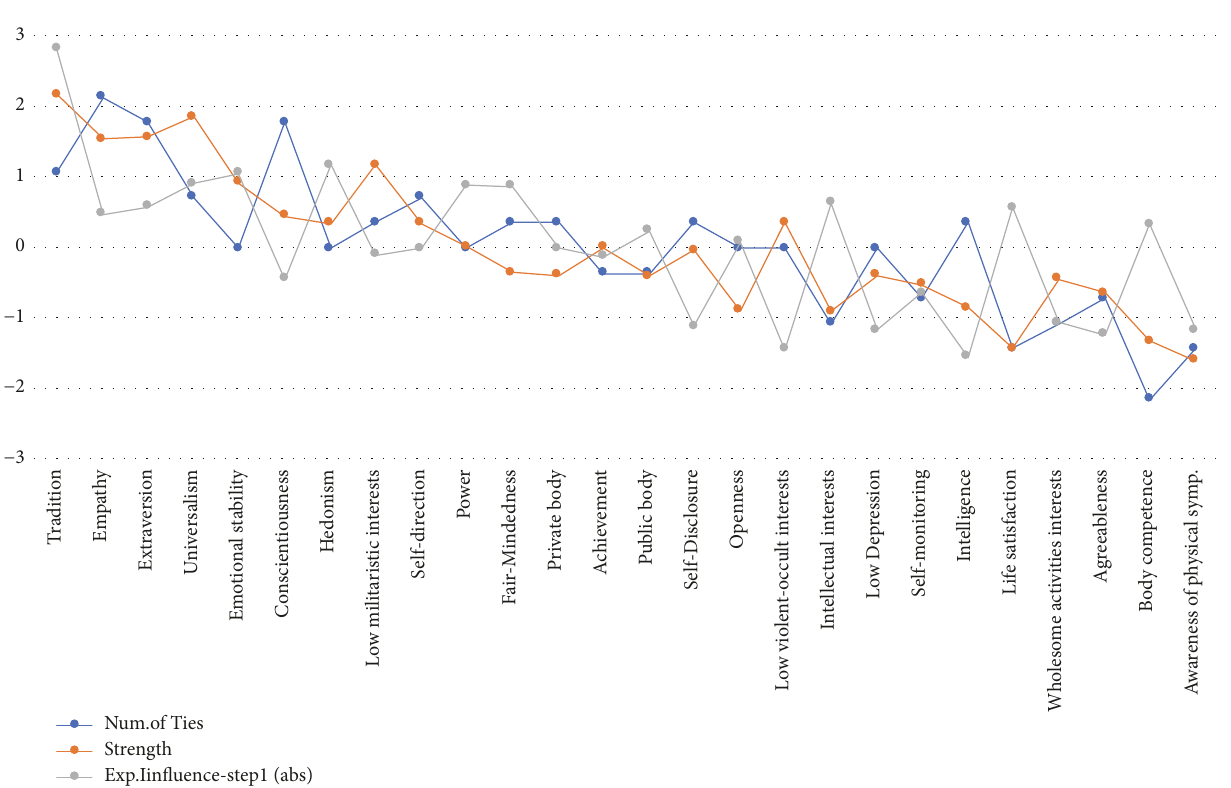
Figure 3: Centrality measures 1: based on node’s direct ties (standardized